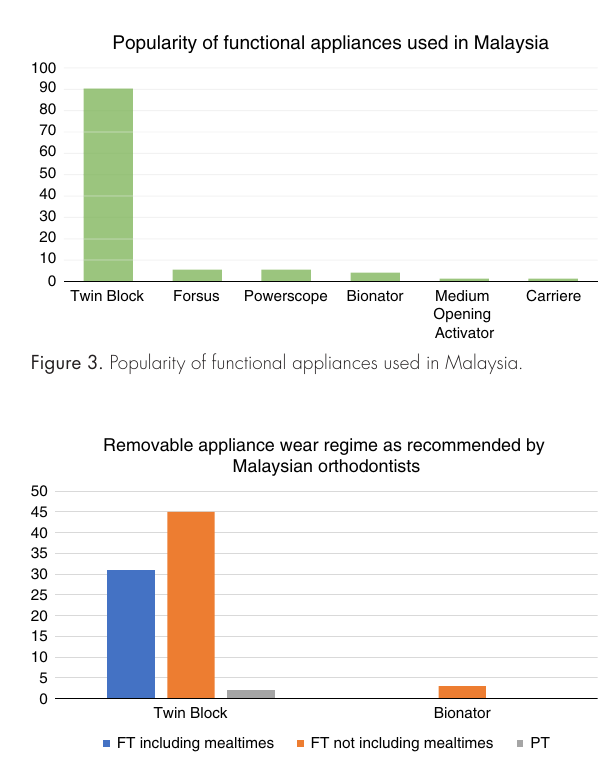
Figure 4. Recommended wear regime of removable functional appliances most used by the respondents.